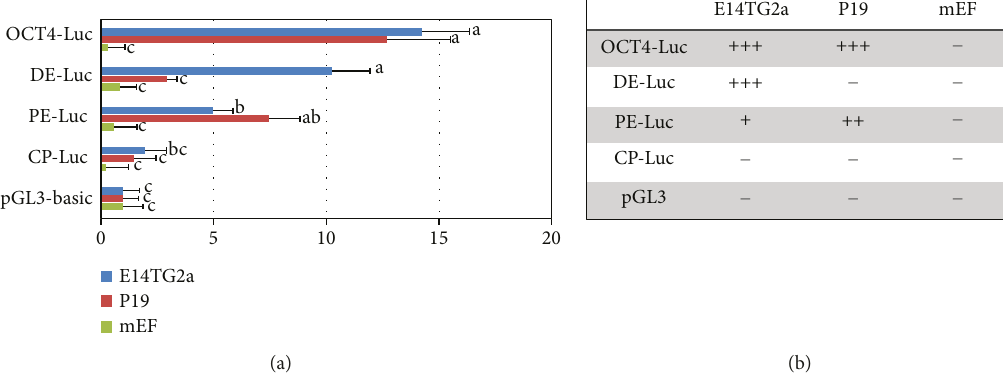
Figure 5: Luciferase reporter analysis of the porcine OCT4 regulatory regions in mouse E14 ES cells, mouse P19 cells, and mouse embryonic fi broblasts. (a) Four constructs containing the di ff erent elements of the OCT4 promoter in the pGL3-basic vector were transfected into mouse E14 ES cells, mouse P19 cells, and mouse embryonic fi broblasts. Luciferase activity was measured 48 h after transfection. Di ff erent letters indicate signi fi cant di ff erences ( P < 0 05 ). Error bars indicate the standard error of the means. (b) Reporter gene expression is tabulated on the right (compared to control): +++, high expression; ++, reduced expression; +, greatly reduced expression; and – , lack of expression in each of the di ff erent pluripotent-state cultured cell types, E14TG2a mouse embryonic stem cells, P19 mouse embryonic carcinoma cells, and mouse embryonic fi broblasts. OCT4-Luc: conserved regions 1, 2, 3, and 4 (CR1, CR2, CR3, and CR4); DE-Luc: CR1 and